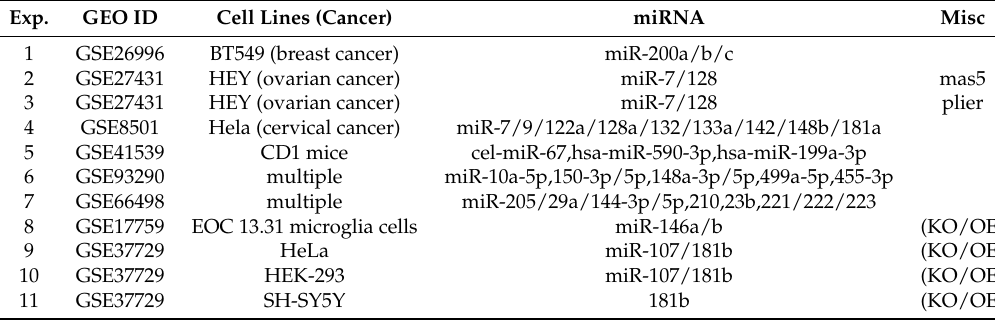
Table 1. Eleven experiments conducted for this analysis. More detailed information is available in the text.